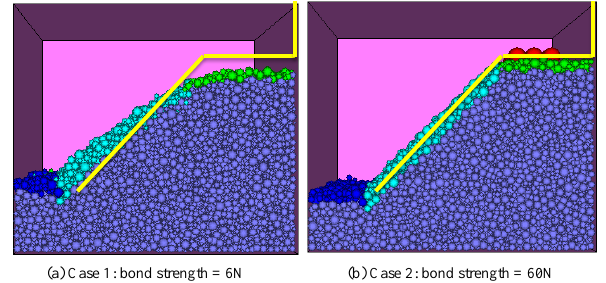
Figure 11 Eventual failure of two modeling cases under loading raft in XY direction(with external Figure 11. Eventual failure of two modeling cases under the loading raft in xy direction (with external load 500 N).